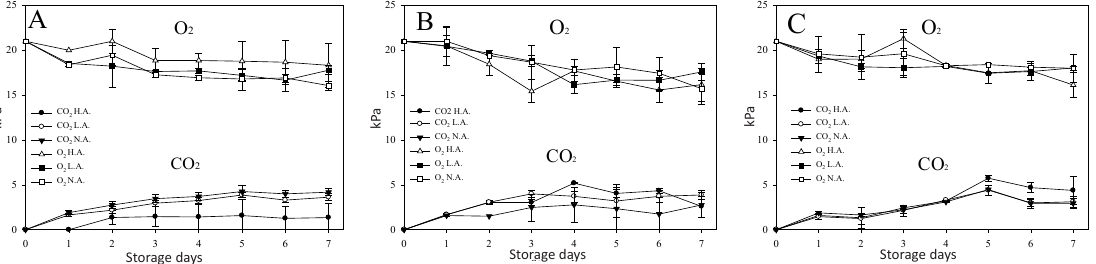
Fig. 3. Influence of the aeration level of the nutrient solution (no aeration -NA-, low aeration-LA-, high aeration -HA-) on the headspace partial pressure of O and CO within the polypropylene basket of fresh-cut red lettuce cultivated in floating system in three different 2 2 growing cycles (autumn -A-, winter -B- and summer -C-) and stored for 7 d at 5 °C. Values are the mean ± SD, (n = 3)